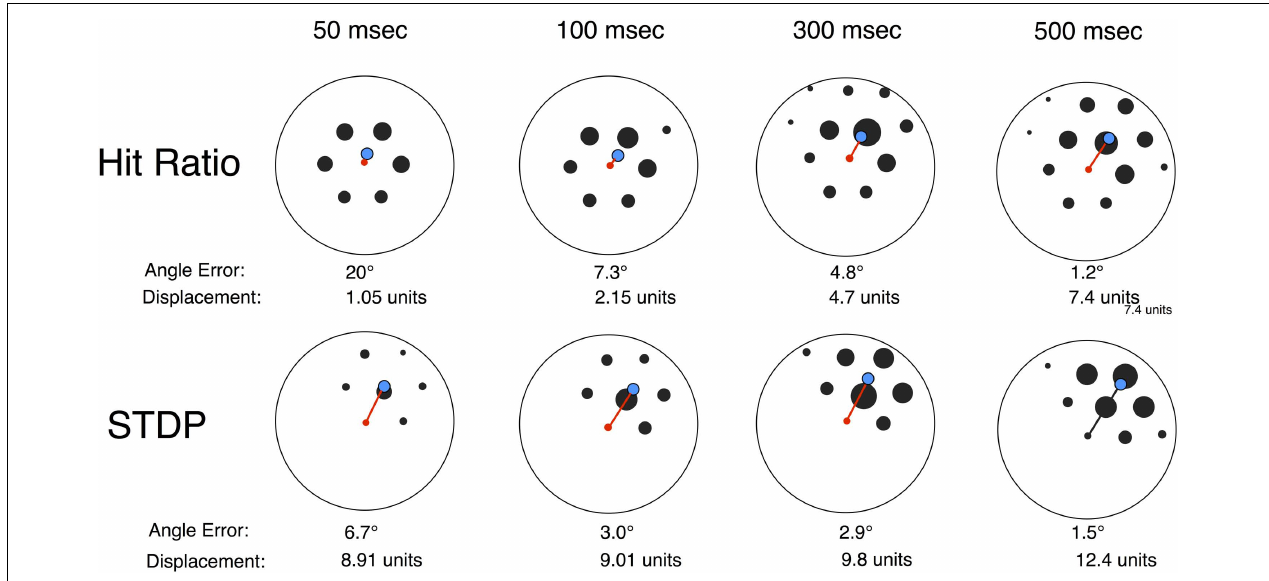
below a threshold are not displayed.The central cell is a red dot, and the centroid is a blue circle. For this representative set, the angle of centroid offset improves with greater pre-synaptic integration time, but all are less than chance (90˚).The distance of centroid displacement also increases with integration time.The second row depicts the connection strengths of the same neuron pairs, where strength is a produced by a spike-time dependent plasticity rule (LTP–LDP).With a STDP learning rule errors are generally smaller, centroid displacement distances are larger, and are less affected by integration time.